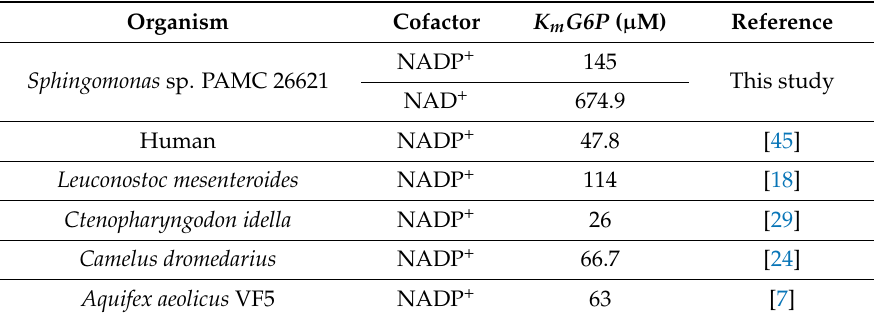
Table 5. The K m value for G6P of G6PD